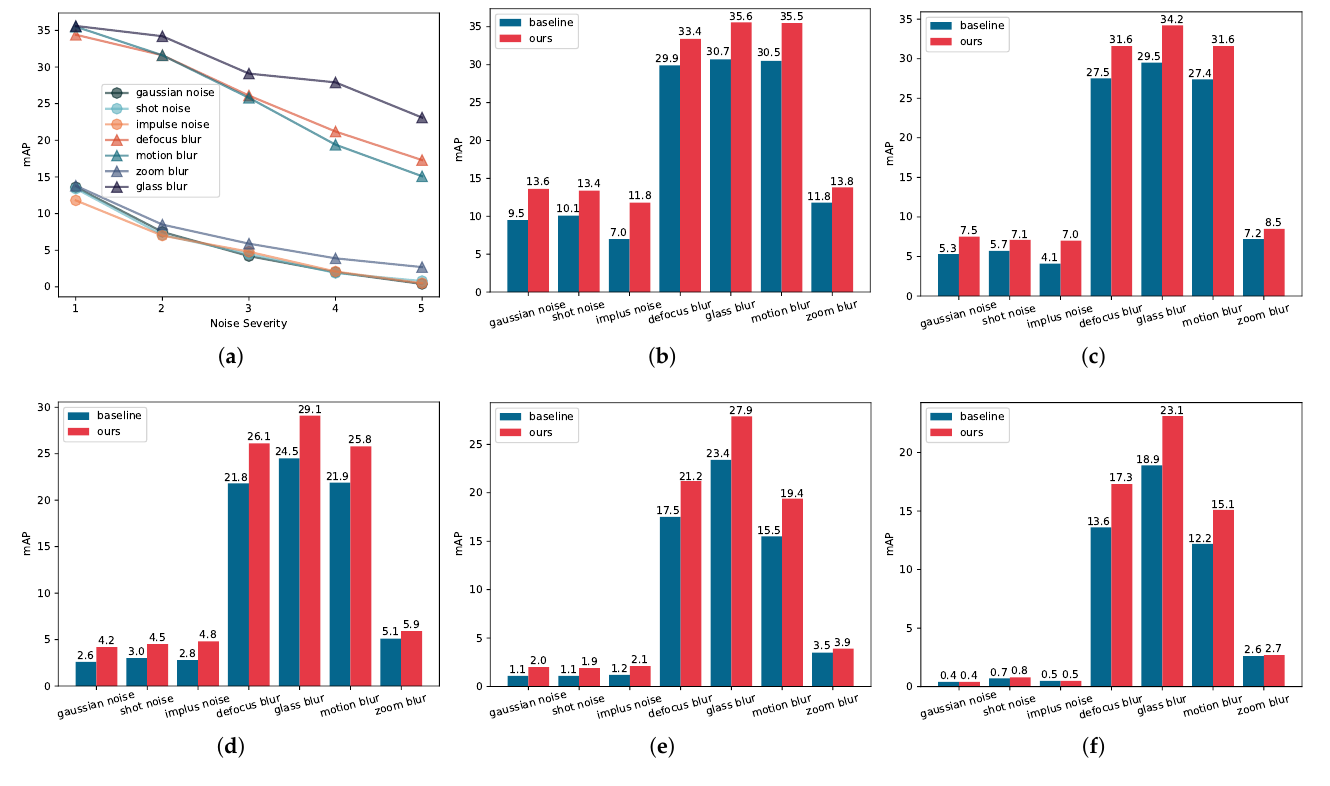
Figure 11. Robustness analysis of our model under different noise disturbances. In ( a ), the triangle symbol indicates low-frequency noise, and the circle icon indicates high-frequency noise. The red bars in ( b – f ) are our model performance, whereas the blue bars are the baseline. From ( b ) to ( f ), the severity of the noise is sequentially increased. ( a ) The performance trend of our model under different levels of noise disturbance. ( b ) Comparison of model performances under different noise disturbances for a noise severity of 1. ( c ) Comparison of model performances under different noise disturbances for a noise severity of 2. ( d ) Comparison of model performances under different noise disturbances for a noise severity of 3. ( e ) Comparison of model performances under different noise disturbances for a noise severity of 4. ( f ) Comparison of model performances under different noise disturbances for a noise severity of